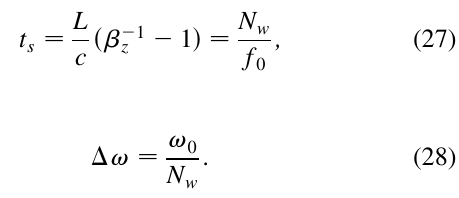
(cid:1) 1200 keV , well spaced apart two frequencies solution; k (cid:1) 1070 keV , at ‘‘grazing intersection k